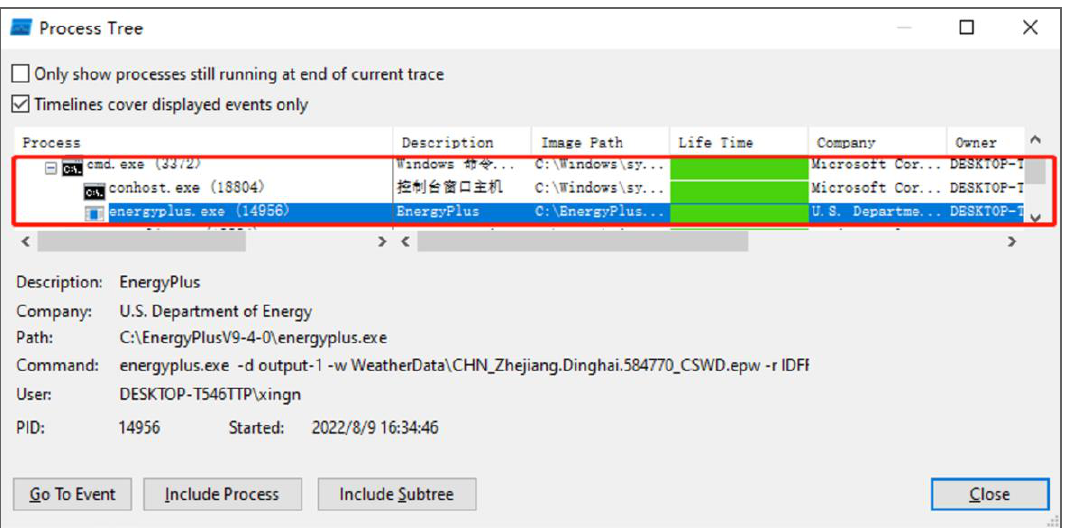
Figure 3. Use of the process tree to monitor the EnergyPlus simulation operation.